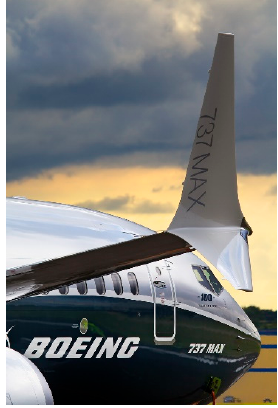
Figure 2. The advance technology (AT) split winglet used for the development of the Boeing 737 MAX wings. Image source: Oleg V. Belyakov, Wikimedia Foundation Inc.—Wingtip Device, 2020 [6].